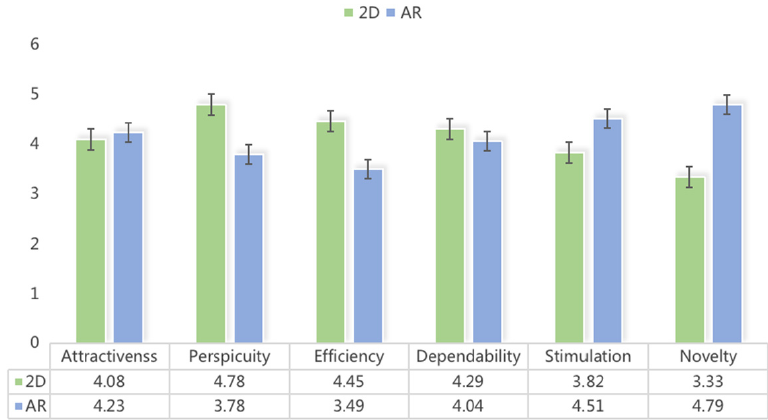
Figure 9. User experience with the 2D and the AR